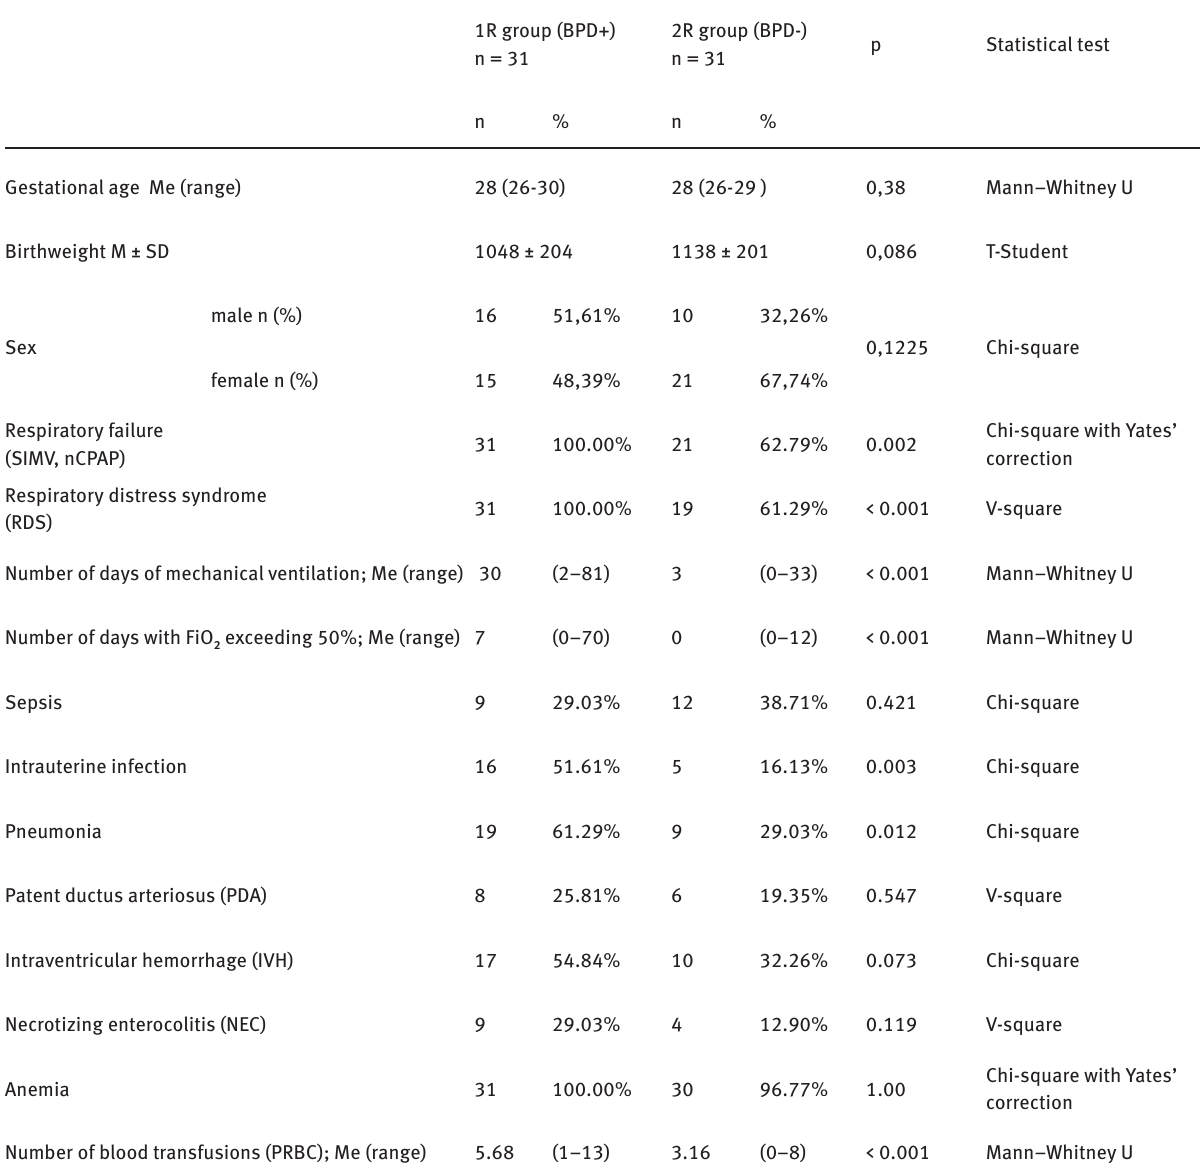
Table 2: Summary of clinical data of newborns with BPD+ (study group) and BPD- (control